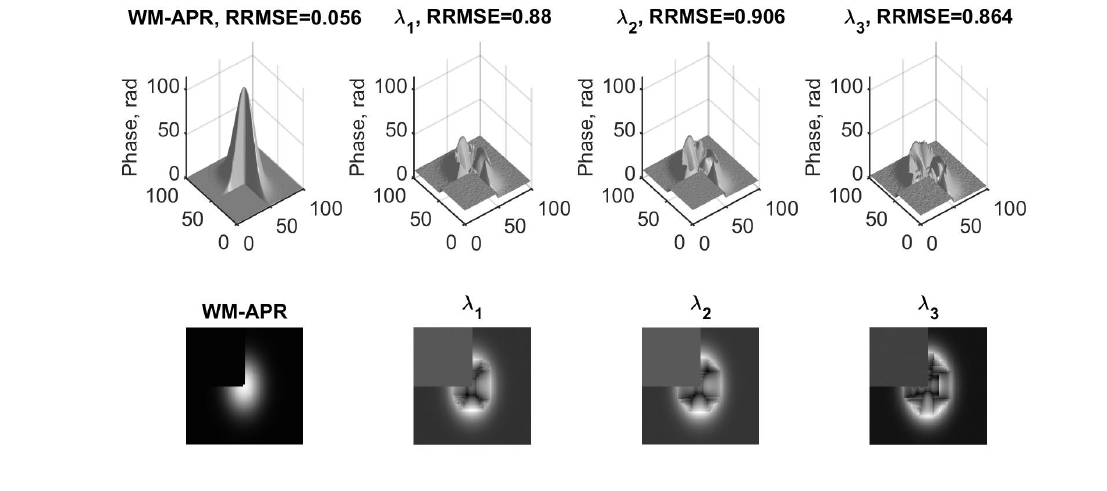
Figure 5. Truncated Gaussian absolute phase reconstructions: RRMSE = 0.056 ( SNR = 6.3 dB, N photon = 1.42), top row - 3D absolute phase surfaces, bottom row - the corresponding 2D absolute phase images. From left to right: WM-APR algorithm, and phase reconstructions obtained separately for λ 1 , λ 2 , λ 3 wavelengths, respectively, followed by the 2D phase